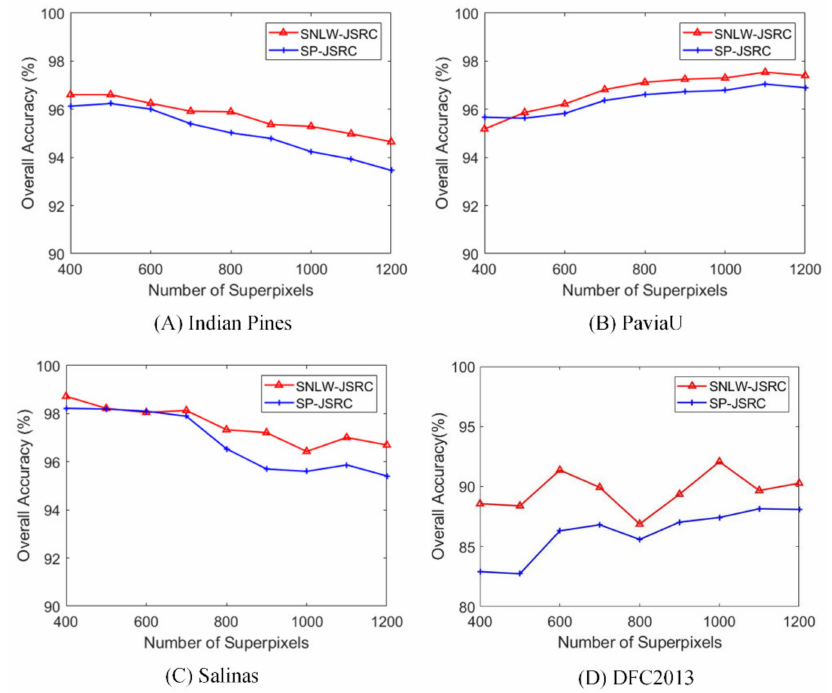
Figure 8. Effects of the superpixel number on four datasets; ( A – D ) are based on Indian Pines, PaviaU, Salinas, and DFC2013 images,